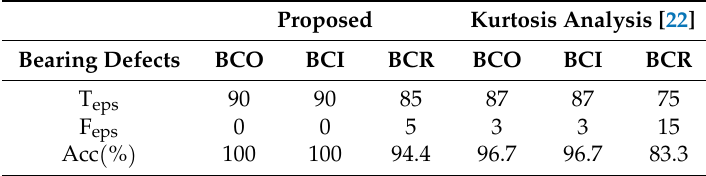
Table 4. The accuracy of bearing defect detection with 400 r/min.